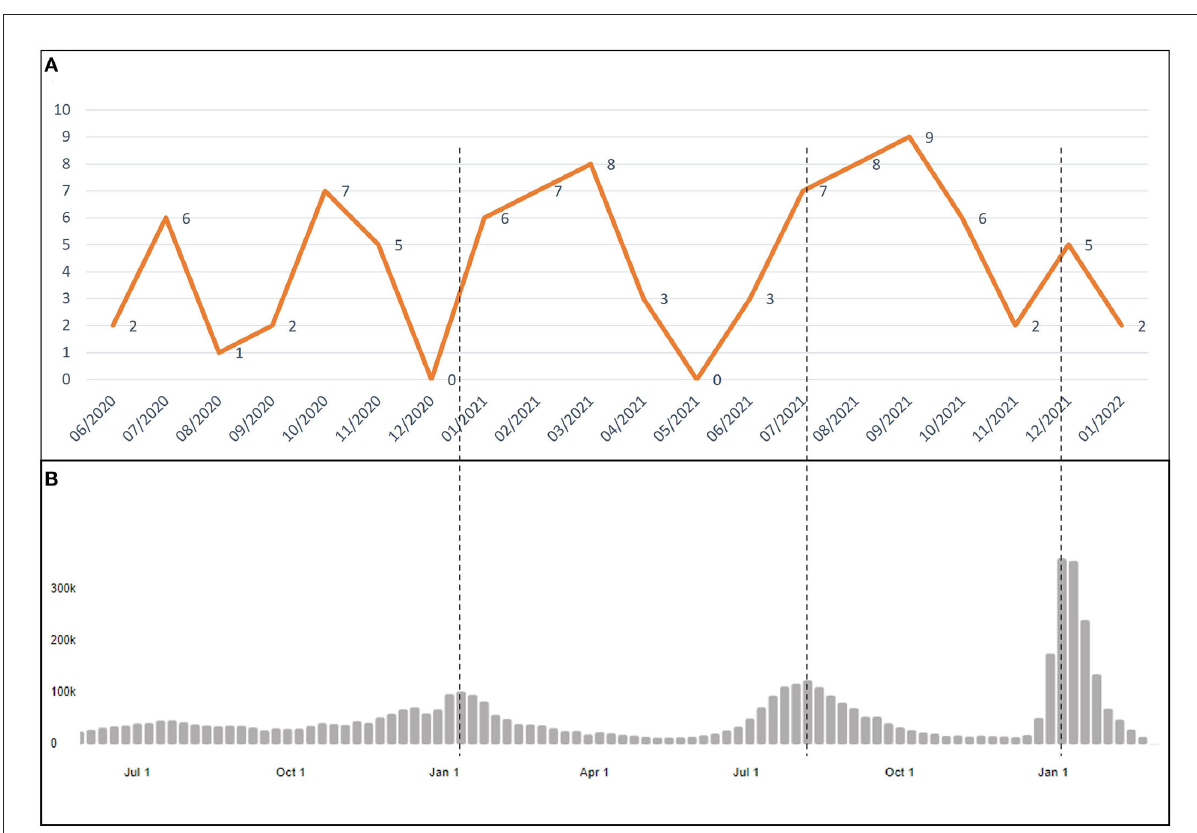
FIGURE1 Temporal distribution of pediatric inflammatory multisystem syndrome, temporally associated with SARS-CoV-2 (PIMS-TS)/multisystem inflammatory syndrome in children (MIS-C) cases from March 2020 to January 2022. (A) Number of cases of PIMS-TS/MIS-C in “Hospital Infantil de Mexico Federico Gomez” by month and (B) COVID-19 cases in general population in Mexico by month reported by